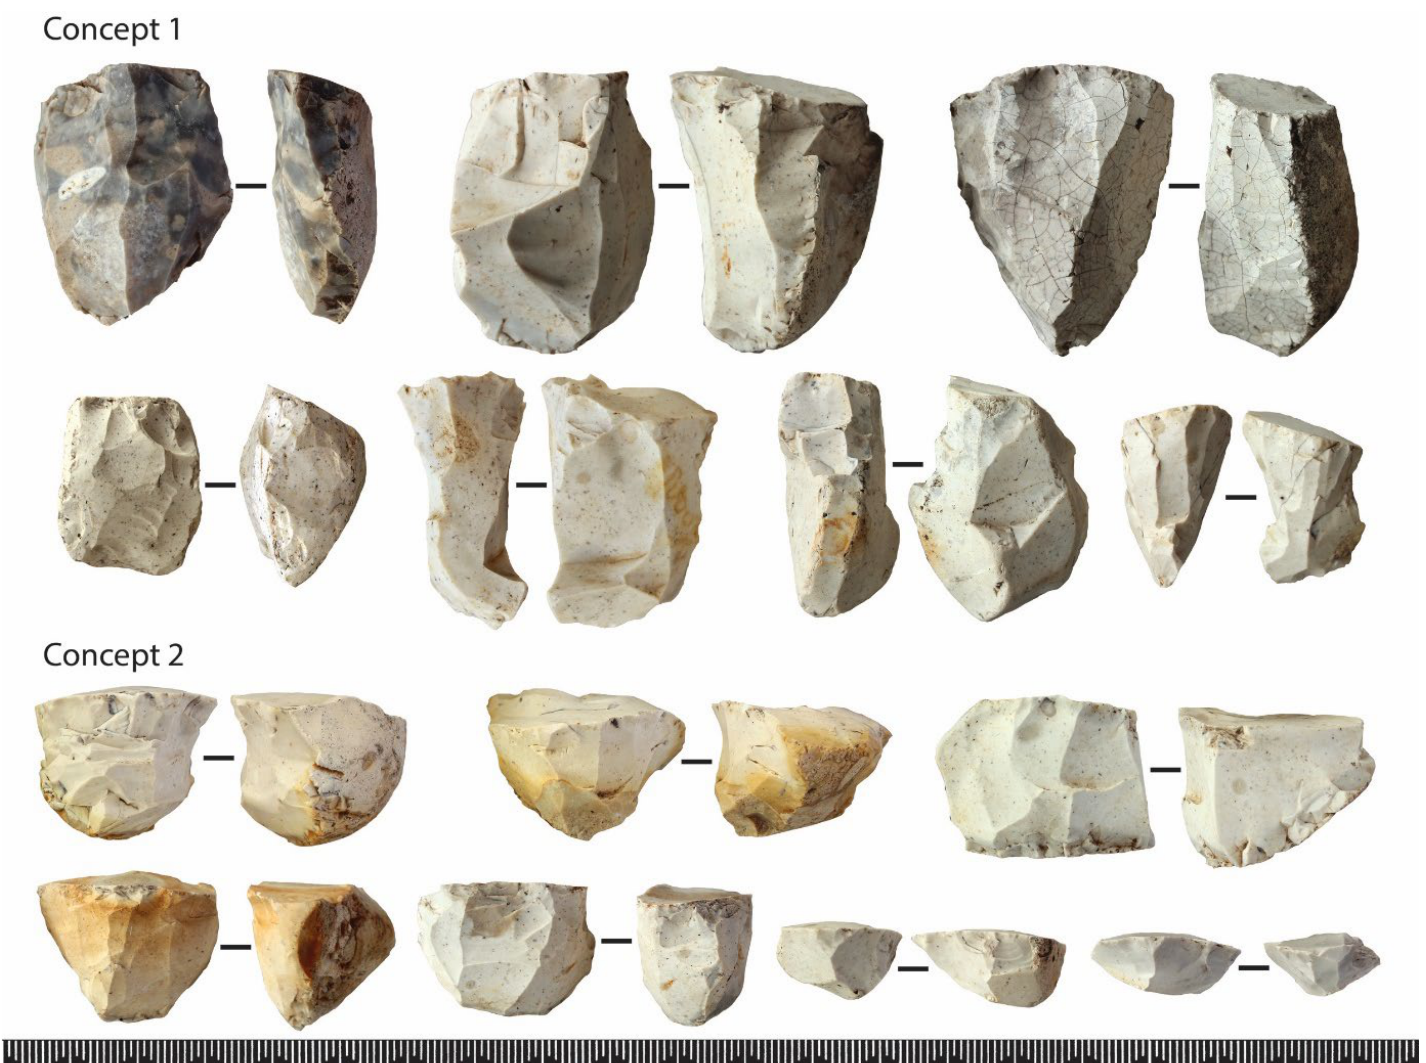
Figure 5. Concept 1 and Concept 2 cores from RPAS (scale bar: cm and Journal of Lithic Studies (2019) vol. 1, nr. x, p. xx-xx DOI: https://doi.org/10.2218/jls.2892